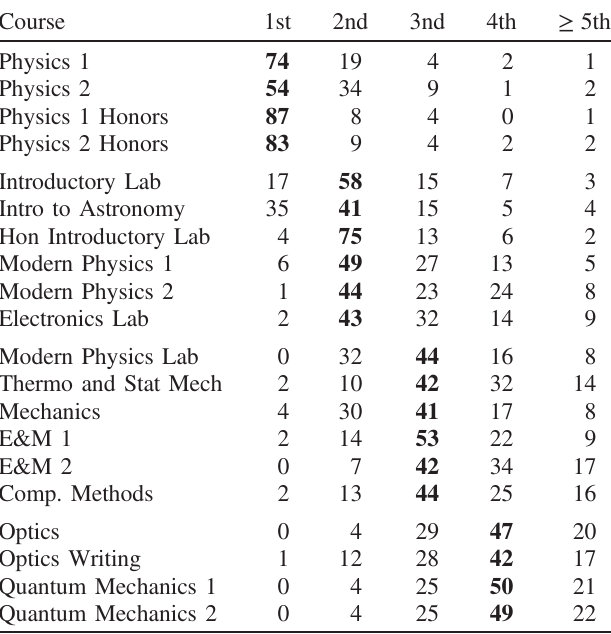
TABLE I. Names of the courses studied and the percentage of students who take each course in a given year. For example, 74% of students take Physics 1 during their first year of university. The bold font indicates the semester in which it was most common for students to take the course. We used the following abbreviations: Laboratory (Lab), Honors (Hon), Thermodynamics and Statis- tical Mechanics (Thermo. and Stat Mech), Electricity and Magnetism (E&M), Computational